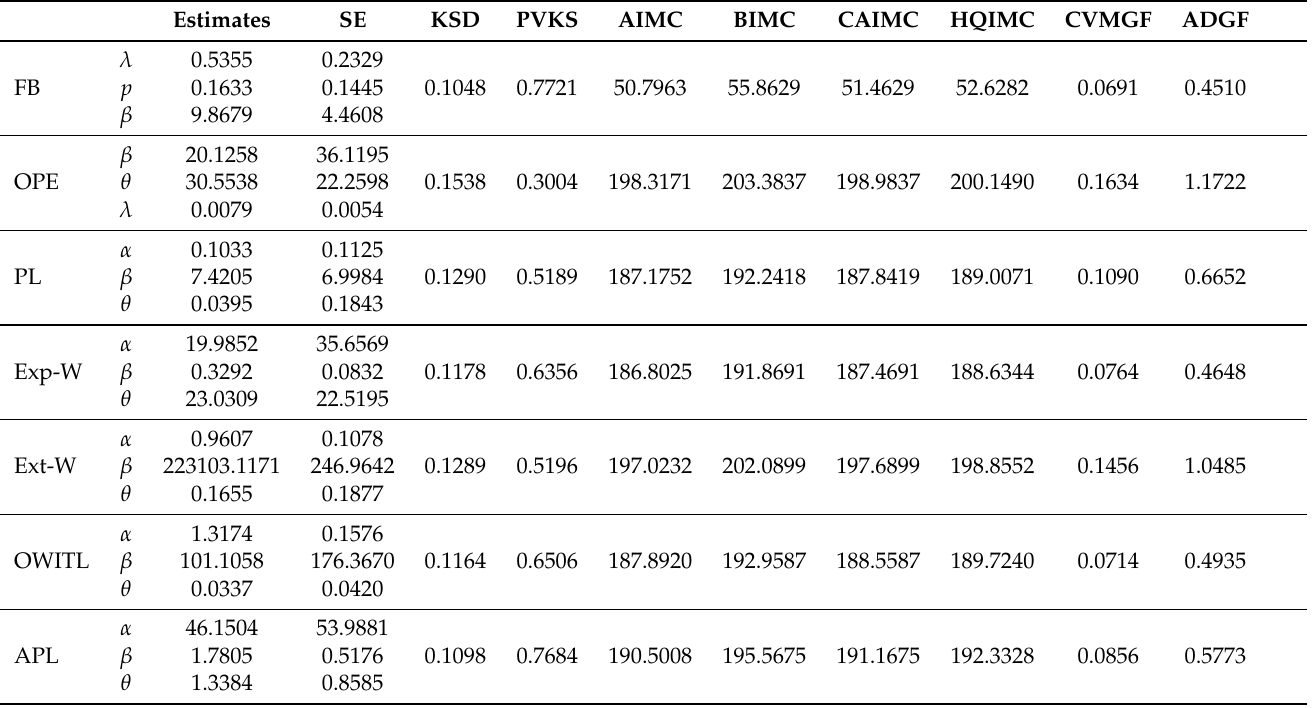
Table 13. MLE with SE and GF measures with different criteria for first set of